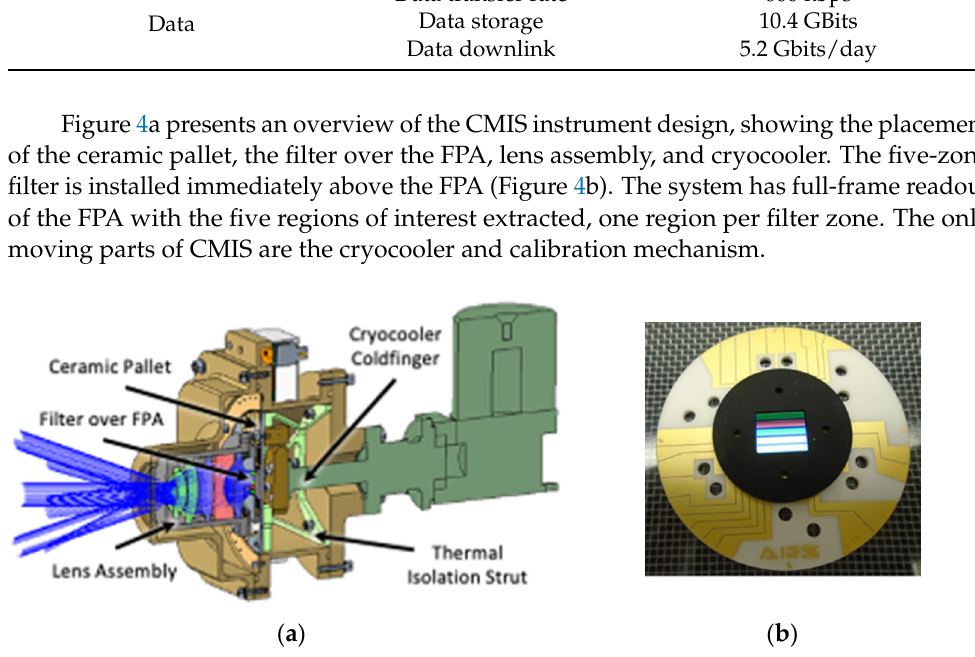
Figure 4. Depictions of the CMIS instrument. ( a ) Cutout of the CMIS instrument highlighting the locations of the ceramic pallet, filter over the FPA and lens assembly. The rays (in blue) entering the lens depict the 50° × 40° field of view. ( b ) Five-zone stripe filter and light shield installed over the FPA on the ceramic pallet.